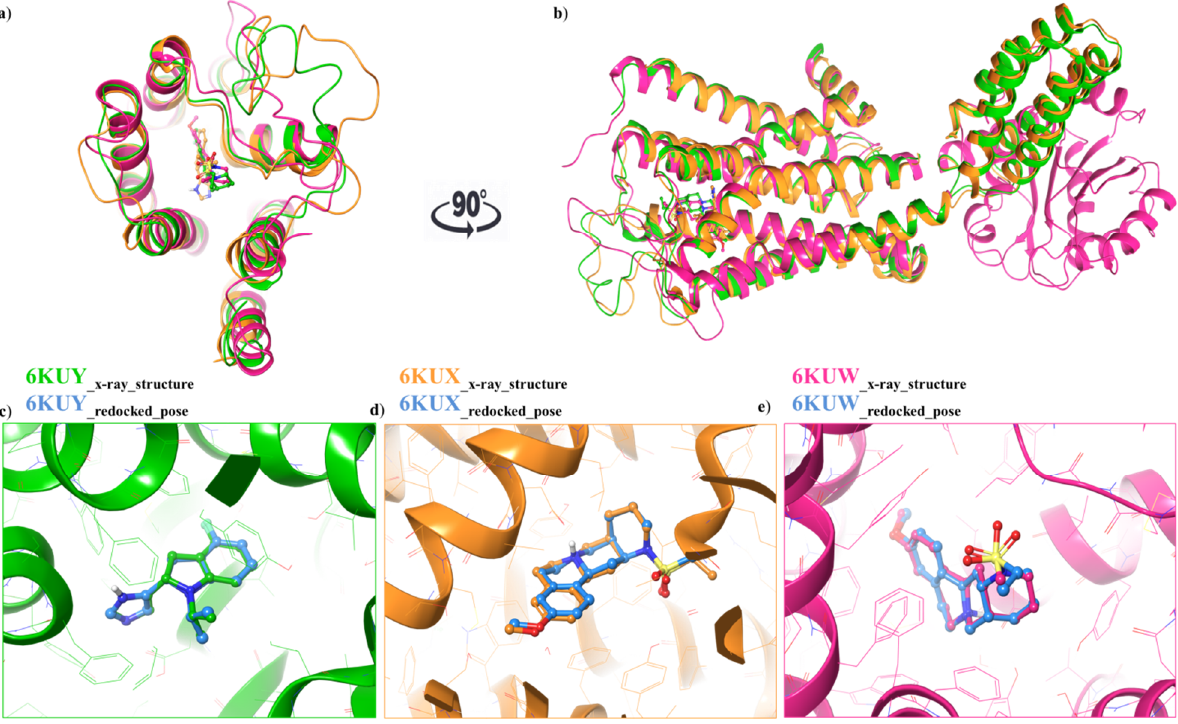
Figure 3. ( a ) Top view: Ribbon representation of overlaid binding orientation of co-crystallized ligands into the binding site of α 2A -AR 6KUY (orange), α 2A -AR 6KUX (green) and α 2C -AR 6KUW (magenta) structures; ( b ) Front view of the superposed α 2A-C -ARSs. Three-dimensional superimposition between the re-docked pose (blue carbon ball and sticks) and the conformation of the native ligand; ( c ) Indole derivative into the binding site of 6KUY; ( d ) Naphthyridine derivative into both 6KUX (green) and ( e ) 6KUW (magenta) X-ray structures. Table 1. Glide score, calculated in kcal/mol, of the best yohimbine, EA and clonidine docked